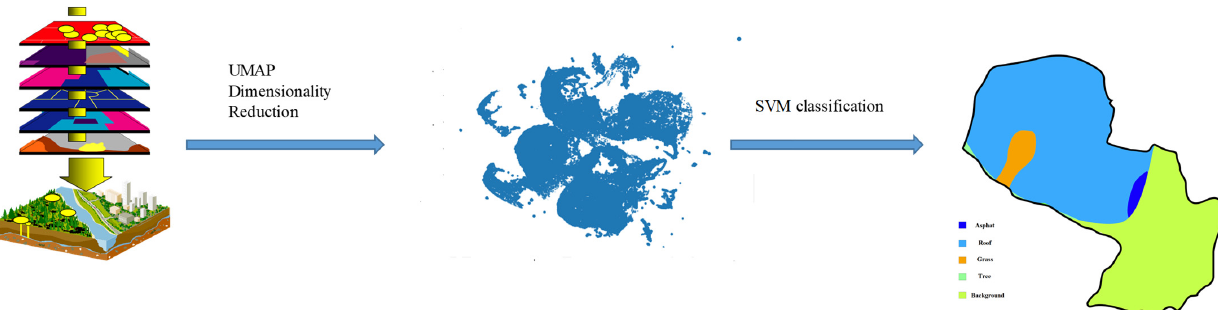
Figure 1. Flowchart of hard classification.